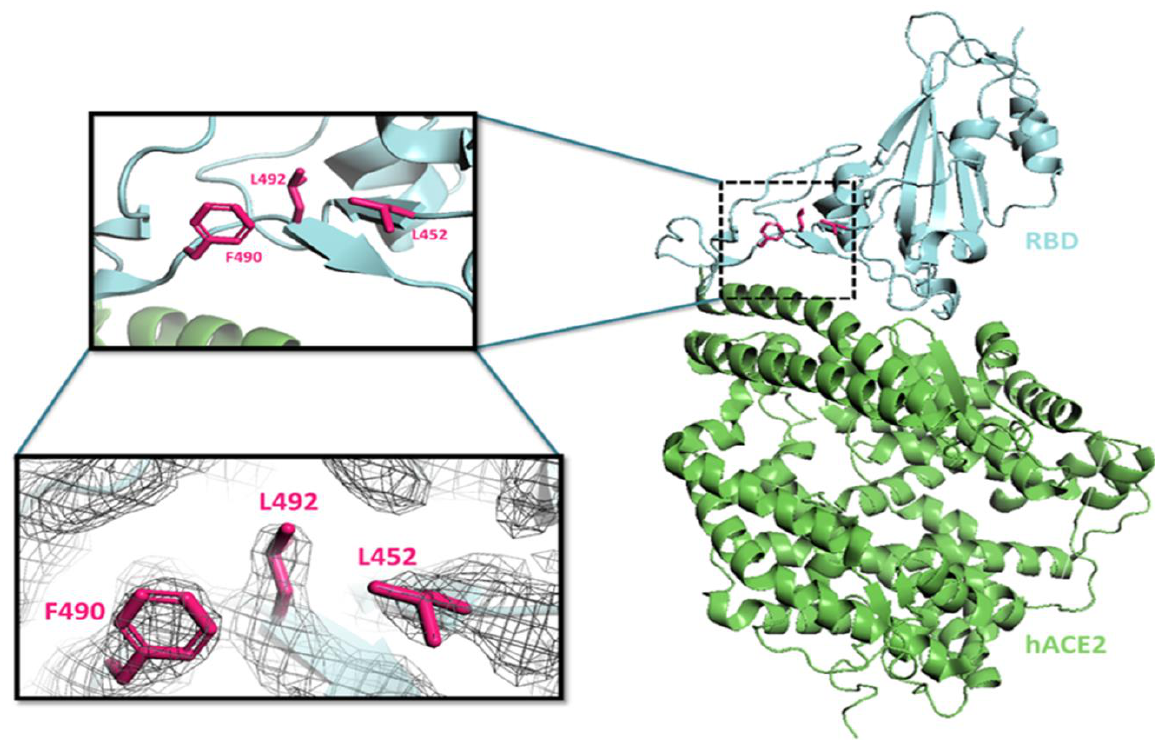
Figure 8. The RBD and hACE2 interactions were taken from the PDB structure (PDB: 6M0J), shown on the right. The structure of hACE2 is shown in green and RBD in cyan. The black dotted box is magnified to represent the L452, L492, and F490 residue in the RBD and is shown in magenta in the upper left box. The electron-density map for these residues (L452, L492, and F490) as shown in the below left box .